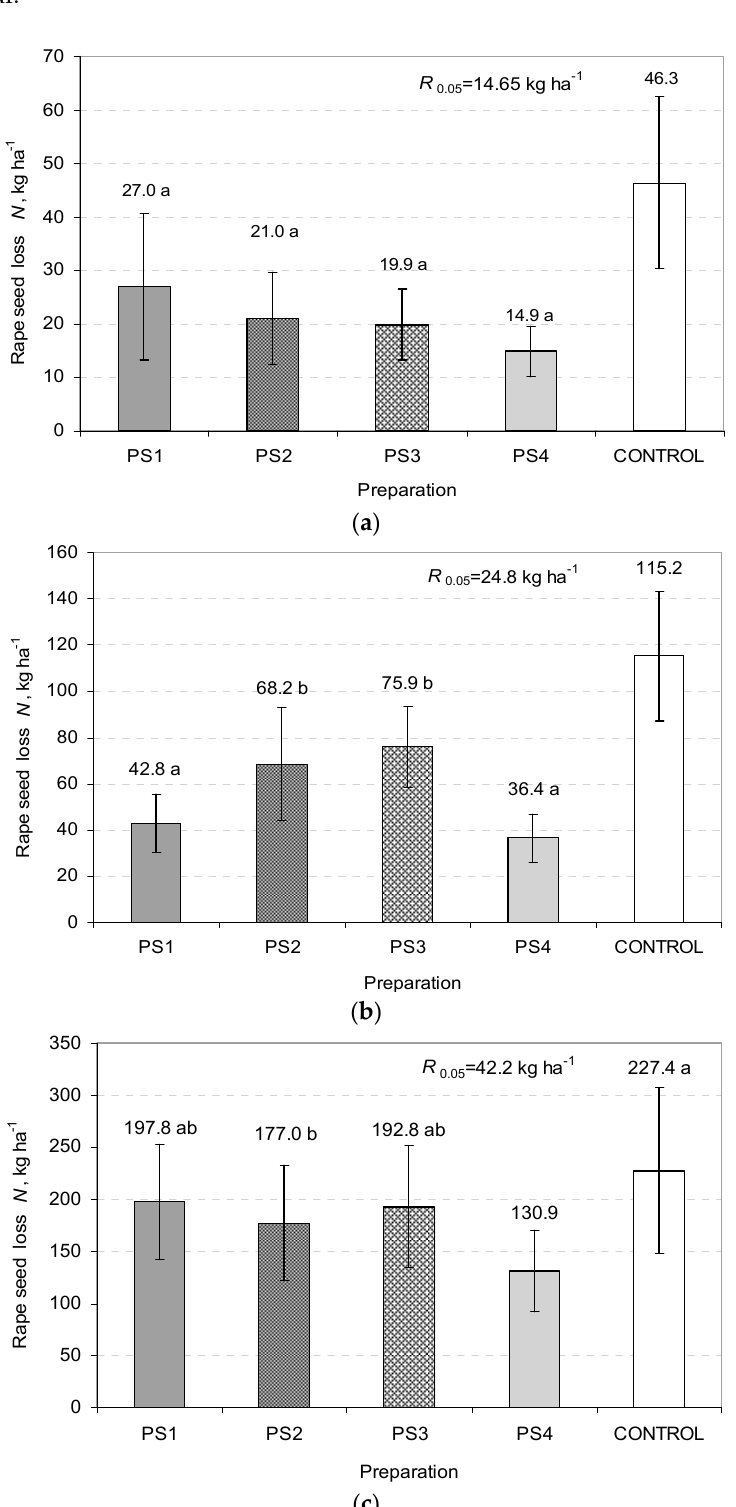
Figure 4. Seed losses due to spontaneous pod shattering N (kg ha − 1 ) in 2014 ( a ), 2015 ( b ), and 2016 ( c ). Any two samples with a common letter are not significantly different ( p > 0.05), as assessed using least significant difference.